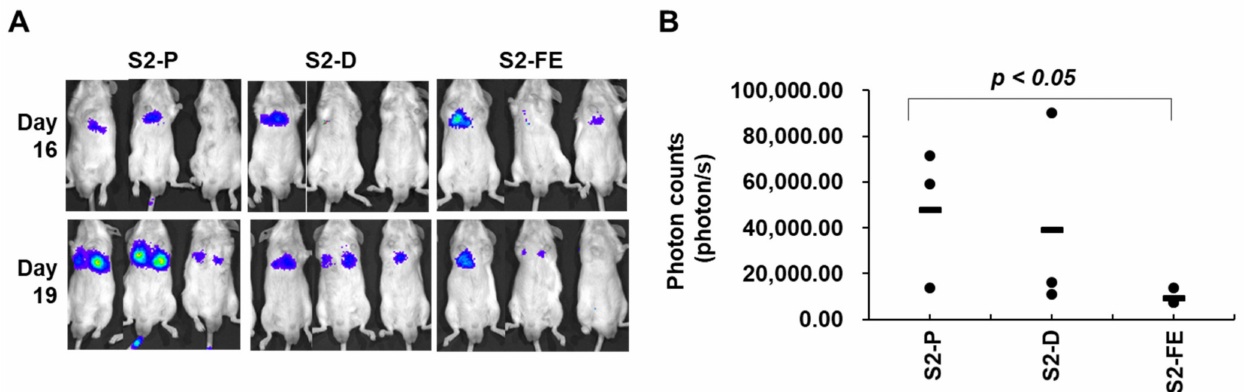
Figure 8. The S2-FE peptide decreased metastasis in mouse models. ( A ) BALB/c mice ( n = 3 per group) were tail-vein-injected with CT26-luc cells (1 × 10 5 cells/mouse) that had been pre-incubated with peptides (final 250 nM). Mice were sacrificed at 3 weeks post-injection. Representative images of in vivo tumor development are shown. Tumor growth was quantified (as photon/s) weekly by IVIS beginning at 6 days post-injection. ( B ) The tumor signal for 19 days was quantified from the photon count ( n = 3), p < 0.05 versus